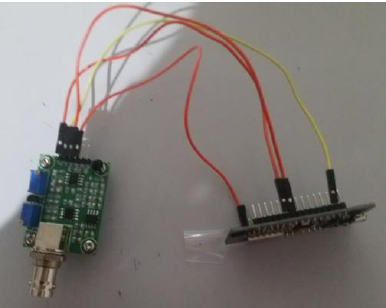
Figure 12. Vibration sensor 801S wiring diagram with